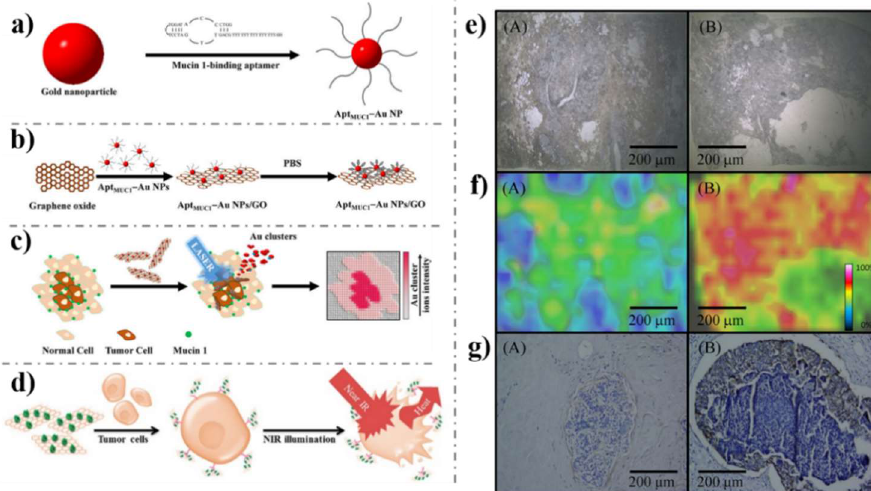
Figure 9. Schematic representation of ( a ) the preparation of MUC1-binding aptamer-modified gold nanoparticles (Apt MUC1–Au NPs) and ( b ) their conjugation to graphene oxide (Apt MUC1–Au NPs/GO) for ( c ) tumor tissue imaging by monitoring Au cluster ions when coupled with laser desorption/ionization mass spectrometry; ( d ) its application with NIR laser irradiation for photothermal therapy of cancer cells; ( e ) optical images; ( f ) laser desorption ionization mass spectrometry (LDI-MS) images of the [Au1] + intensity distributions in tissues after incubation with Apt MUC1–Au NPs/GO for 1 h. ( g ) Immunostaining of MUC1 by MUC1 antibody (VU4H5) in tissues. ( A ) Normal breast and ( B ) tumor breast tissues. Reproduced from [155] ( a – c , e – f ), with permission from Nature, 2015; Reproduced from [156] ( d ), with permission from American Chemical Society, 2015.